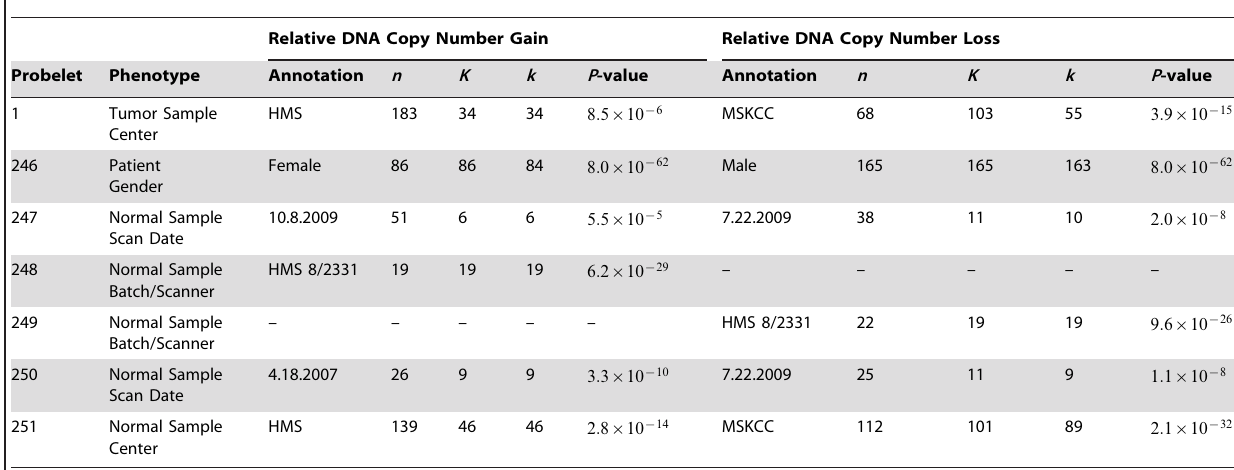
Table 1. Enrichment of the significant probelets in TCGA